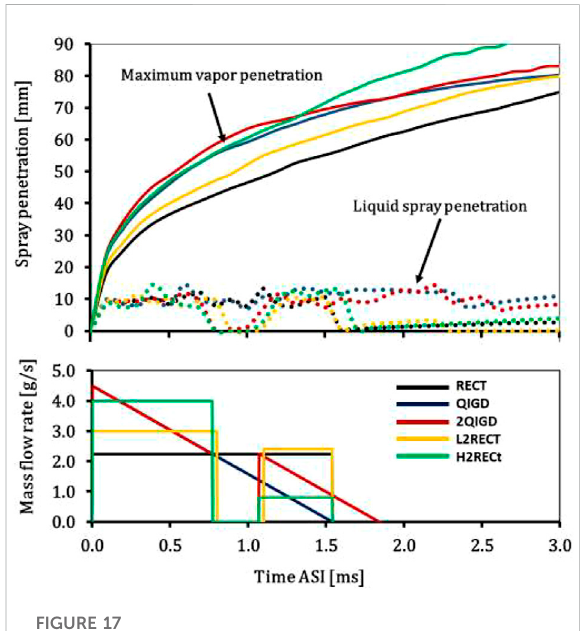
FIGURE 17 Simulated spray penetration of different injection patterns.